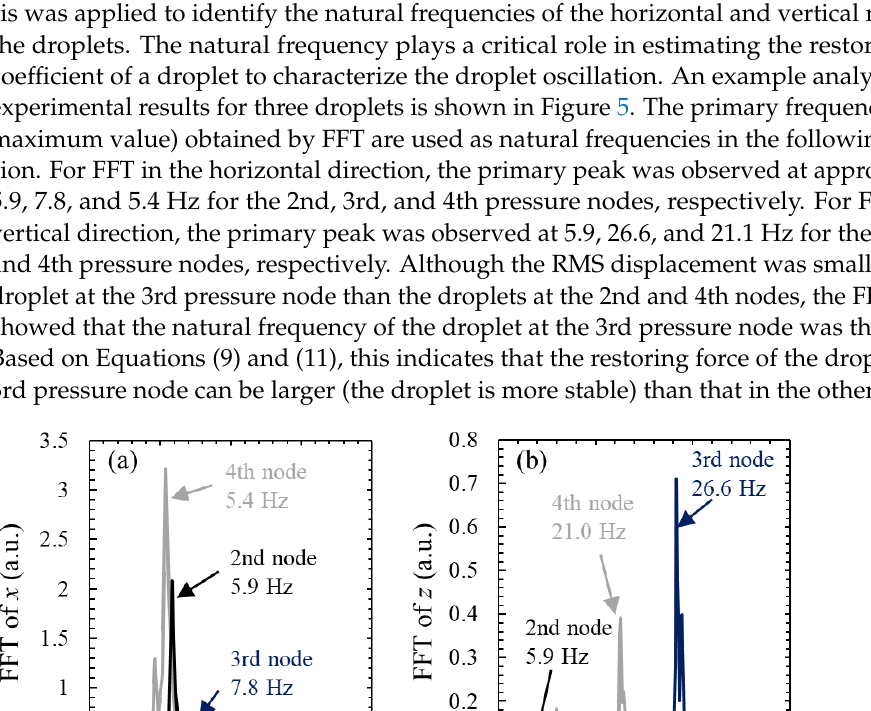
Figure 6. FFT results for all cases. The primary frequency for the ( a ) horizontal and ( b ) vertical os- cillations. ( c ) Frequency ratio for each case. The average values were used for each plot, and the error bars represent the standard deviations of the three experiments. The dashed line represents the calculated value in a previous study. Data from [18]. Additionally, we introduced the natural frequency ratio f z / f x to characterize the oscil- lation dynamics of the levitated droplet in Figure 6c. In a previous study [18], the